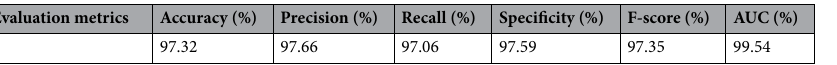
Table 1. Performance of the EfficientNet-B0 for discrimination between clean and contamination